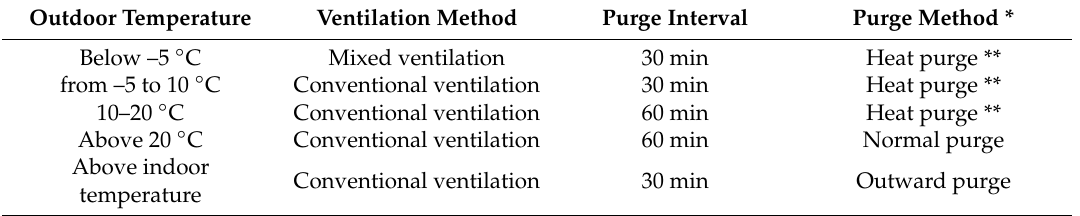
Table 5. Optimum ventilation and purge strategies according to outdoor temperature.